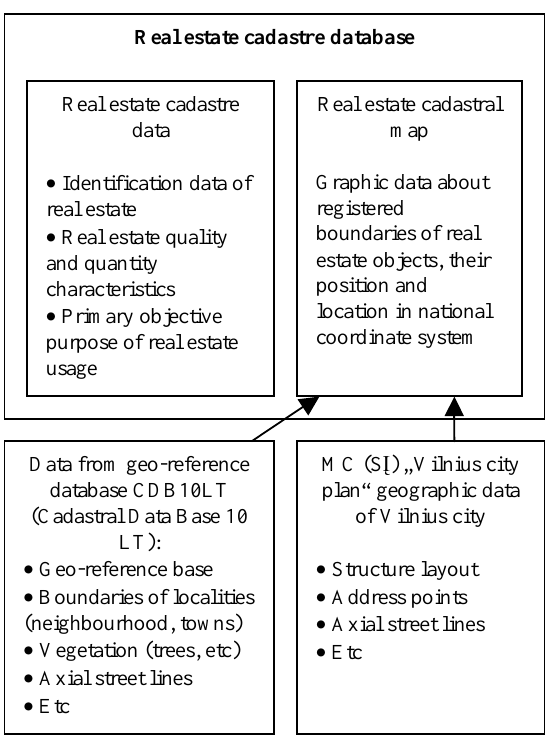
Fig 1 . The chart of data in Real estate cadastre database